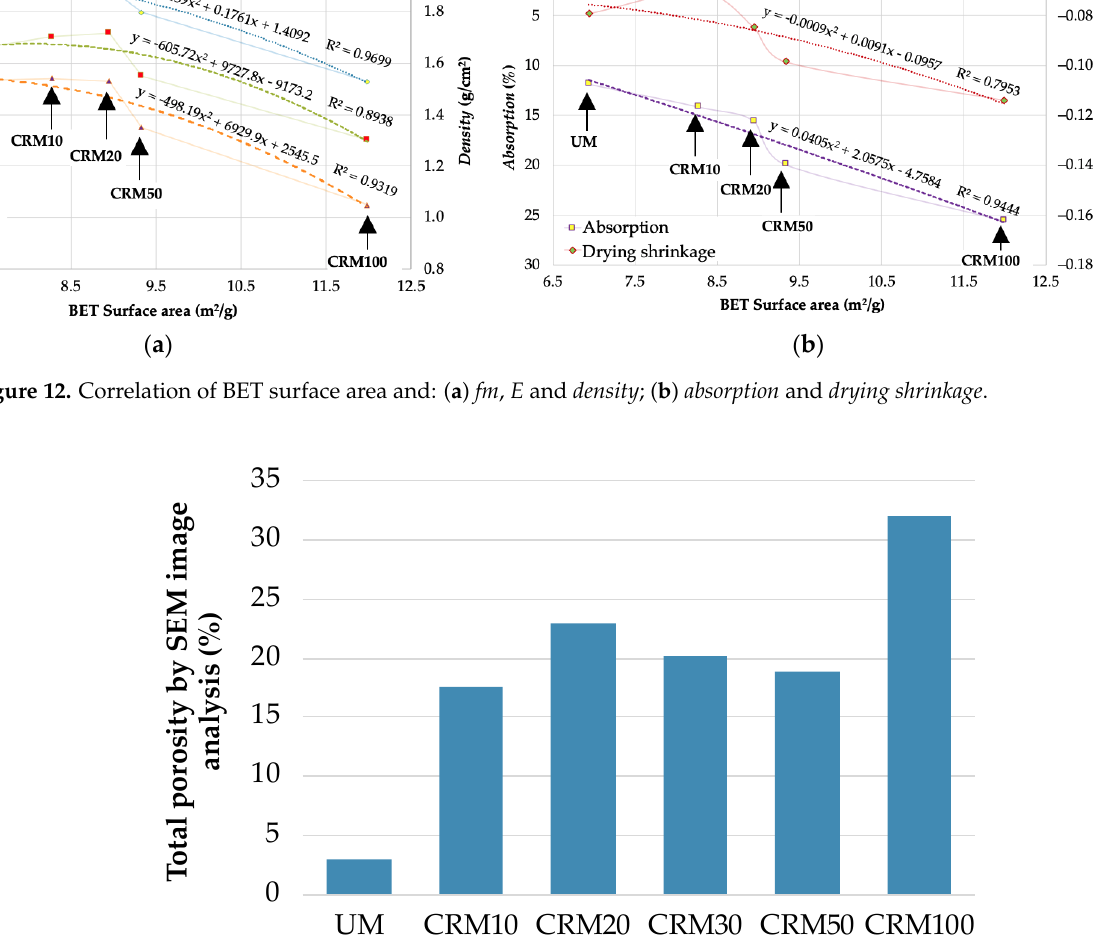
Figure 14. Correlation of Porosity by SEM and: ( a ) fm , E and density ; ( b ) absorption and drying shrinkage .